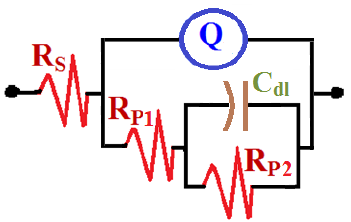
Figure 8. The circuit that fits impedance plots represented in Figures 5 – 7.